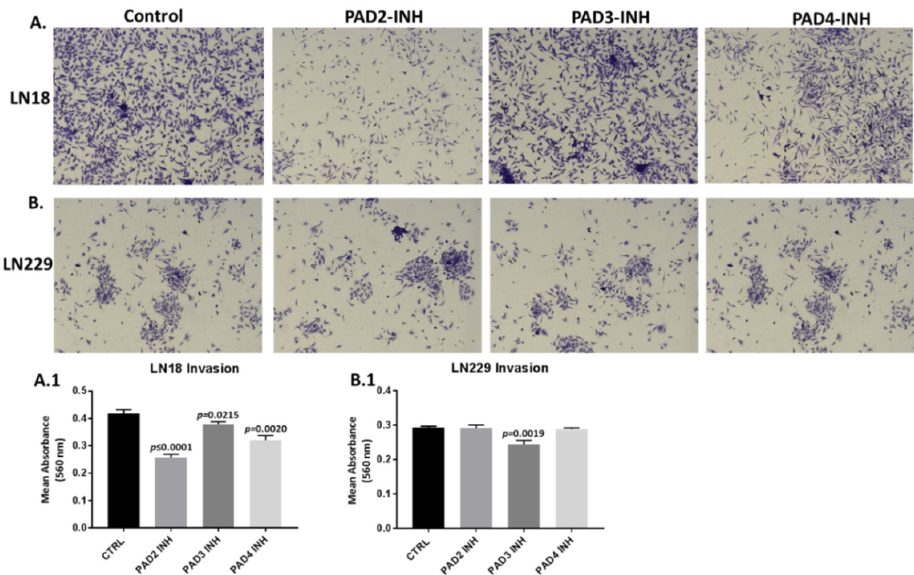
Figure 7. Cell invasion is differently affected by PAD isozyme-specific inhibitors in LN18 and LN229 GBM cells. Representative images of LN18 ( A ) and LN229 ( B ) cells following 16 h treatment with the three PAD-isozyme specific inhibitors, compared to control (DMSO)-treated cells following crystal violet treatment (imaged using a 10× objective). A.1. The corresponding histogram for the MTT assay for LN18 cell invasion following 16 h treatment with all three PAD isozyme-specific inhibitors. B.1. The corresponding histogram for the MTT assay for LN229 cell invasion following 16 h treatment with all three PAD isozyme-specific inhibitors. Exact p -values are indicated, and error bars show SD ( n = 3 biological and 3 technical replicates for all).